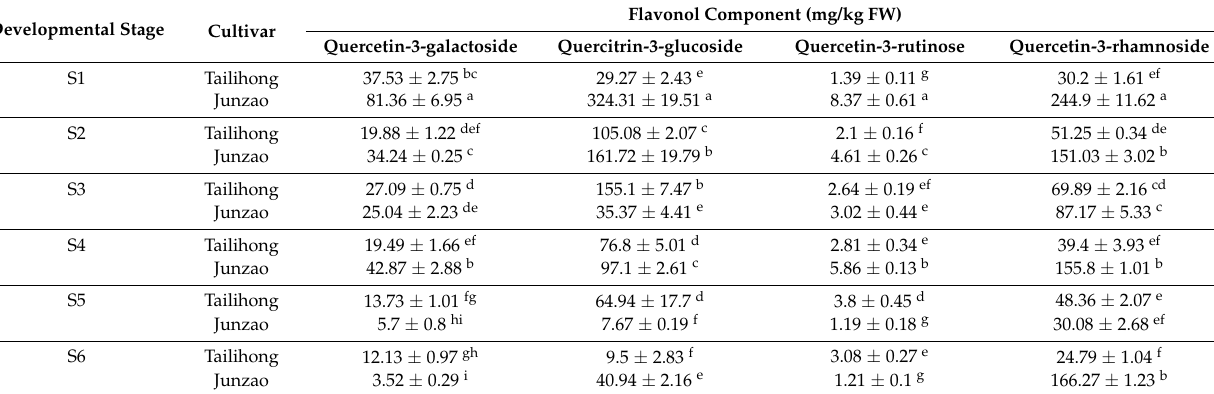
Table 2. Contents of individual phenolics in the skins of ‘Tailihong’ and ‘Junzao’ jujube fruit at different developmental